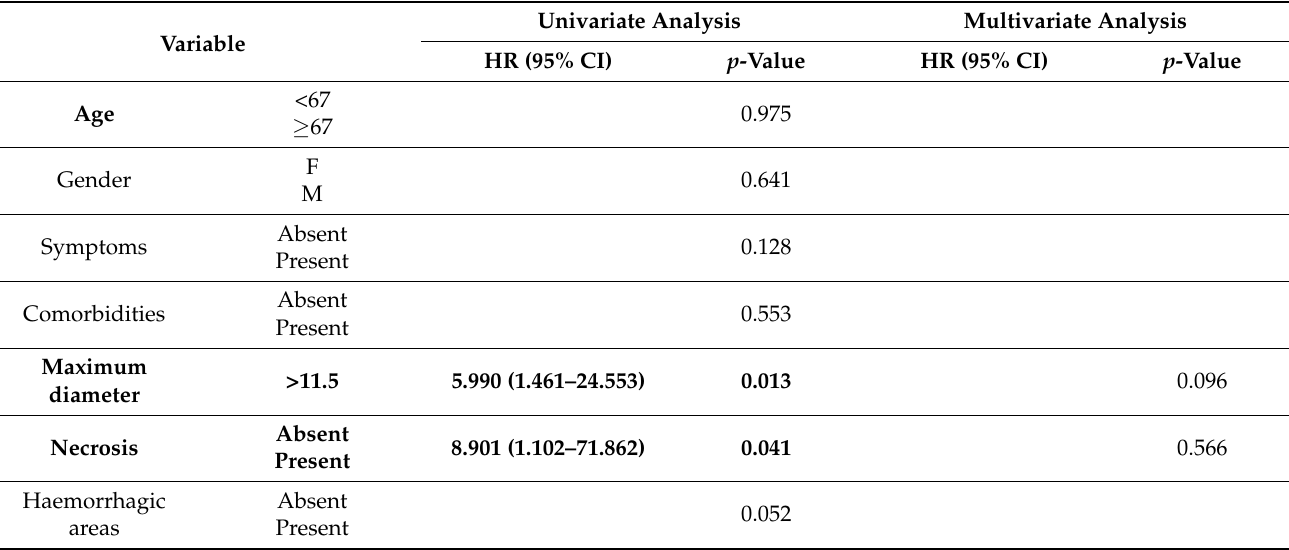
Table 6. Univariate and multivariate analyses for the